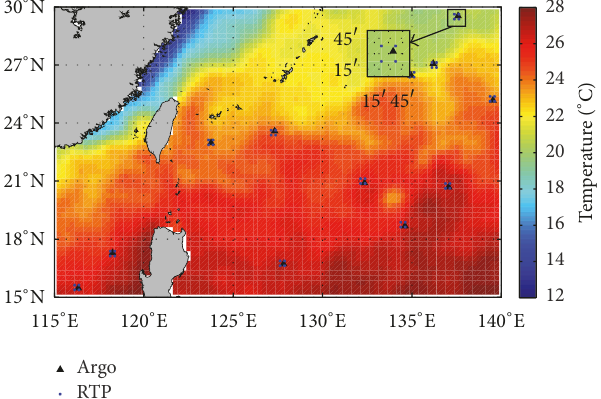
Figure 4: Distribution of Argo and RTP in the reconstruction (Jan 06, 2010): the background represents SST ( ∘